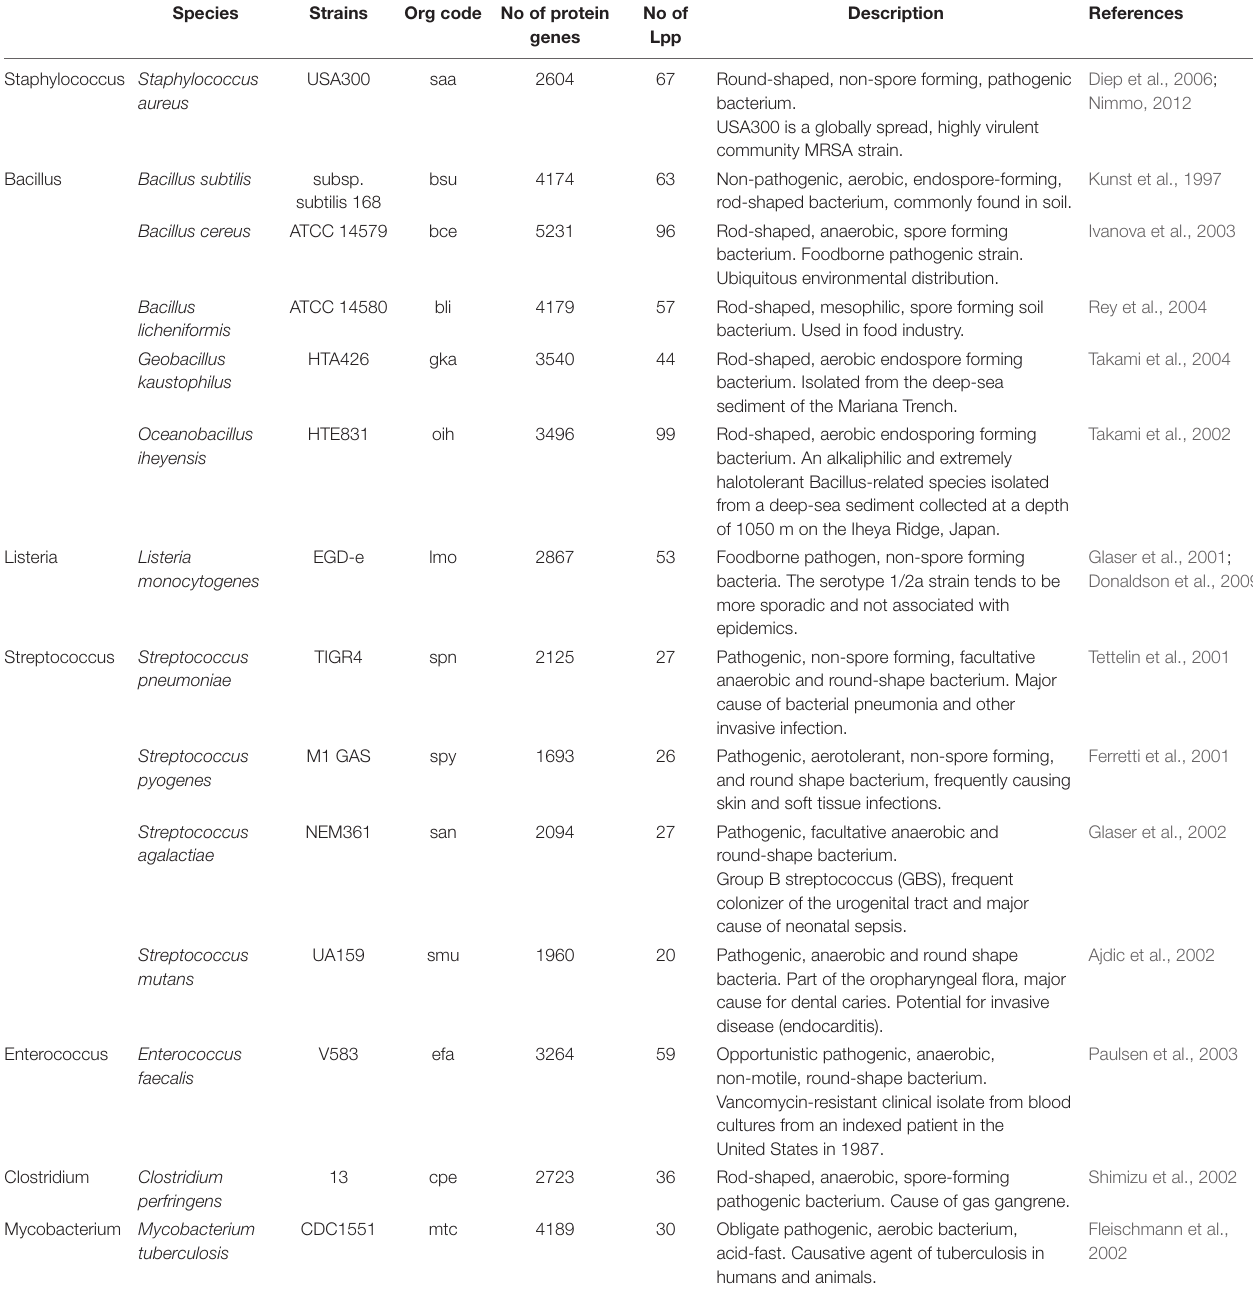
TABLE 1 | Number of Lpp of selected Gram-positive bacterial strains. Species